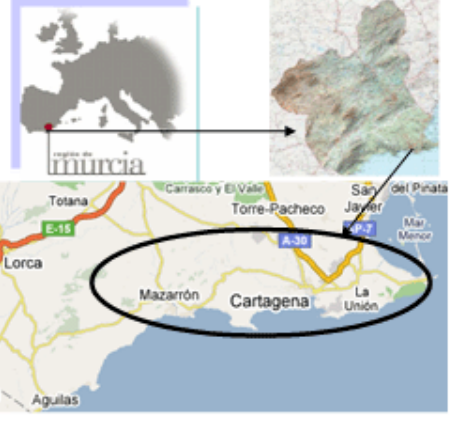
FIGURE 1 . The location of the area